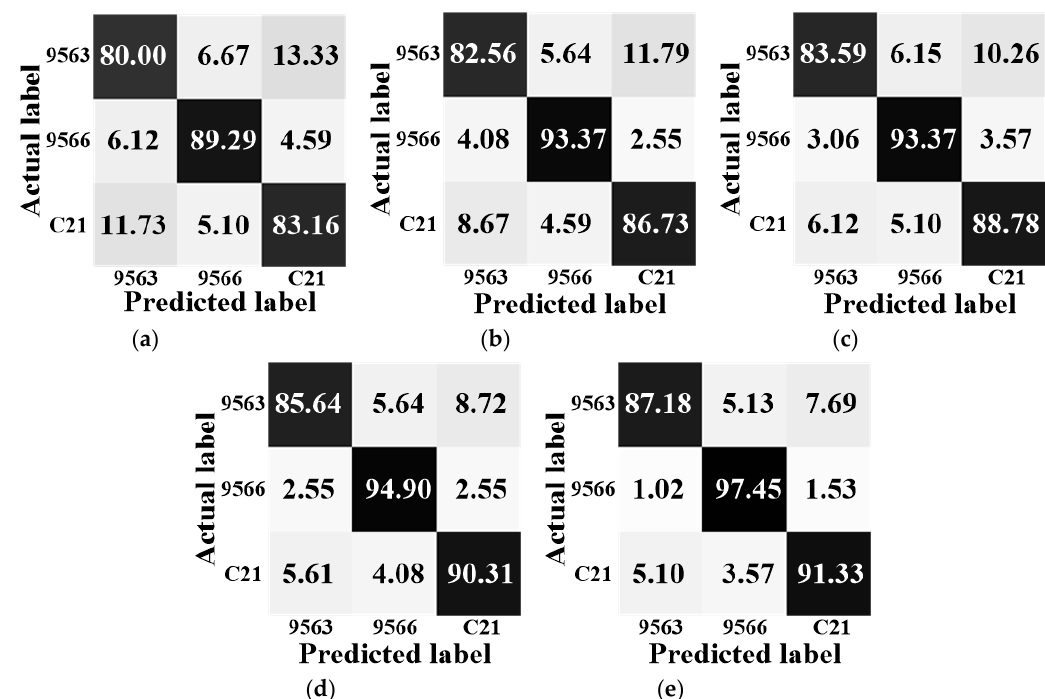
Figure 4. The confusion matrices for the BMP2 configurations. ( a ) SR; ( b ) MSR; ( c ) JSR; ( d ) LSR; ( e )